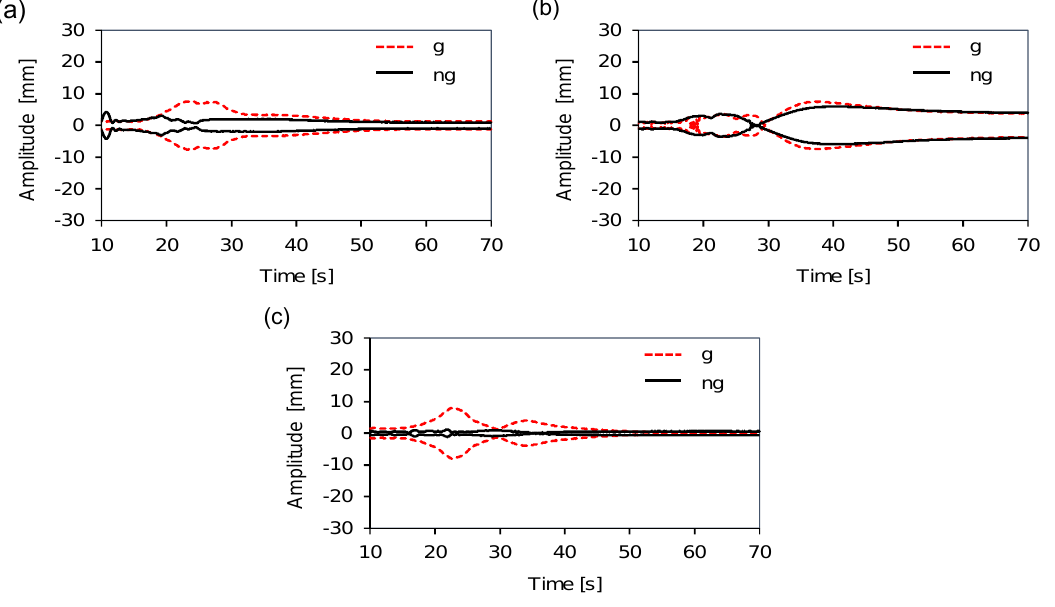
Figure 3. Displacement envelopes: ( a ) X f counter load, ( b ) Z r counter load, ( c ) Y f middle load. Subsequently, for each point i ∈ { X r , Y r , Z r , X f , Y f , Z f } and under each scenario